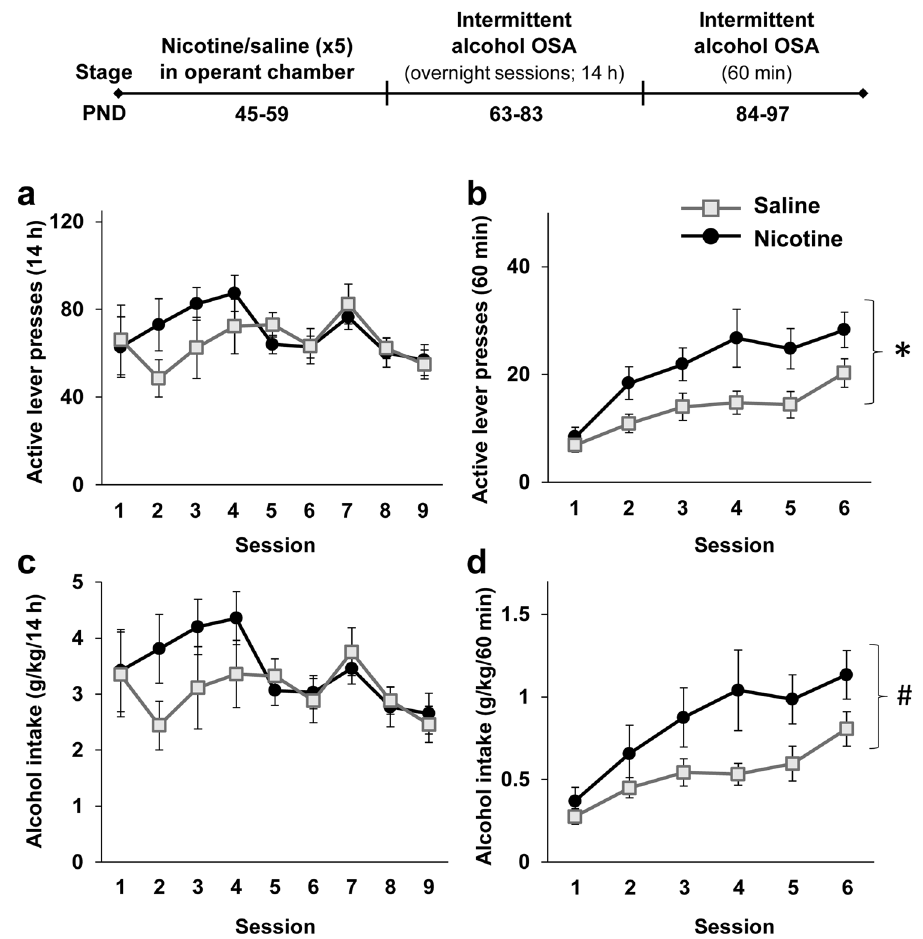
confined for 2 h to the operant self-administration (OSA) chambers. On PND 63 rats began intermittent overnight operant alcohol self-administration training three days a week (fixed ratio 1; FR1) for 3 weeks. On PND 84, rats began intermittent operant training (FR1) of 60 min, three days a week for 2 weeks. ( a–d ) Means ± SEM of the number of active lever presses ( a and b ) or alcohol intake normalized to body weight ( c and d ) during the overnight ( a and c ) or 60-min ( b and d ) sessions. Mixed-model ANOVA; Overnight sessions: A main effect of Session for active-lever presses [F(8,112) = 2.90, p < 0.01] and for alcohol intake [F(8,112) = 3.13, p < 0.005], but no significant main effect of Pre-treatment and no significant Pre-treatment X Session interaction (p > 0.05); 60-min sessions: A main effect of Pre-treatment for active lever presses [F(1,14) = 5.61, p < 0.05] and marginally significant for alcohol intake [F(1,14) = 4.54, p = 0.051], a main effect of Session